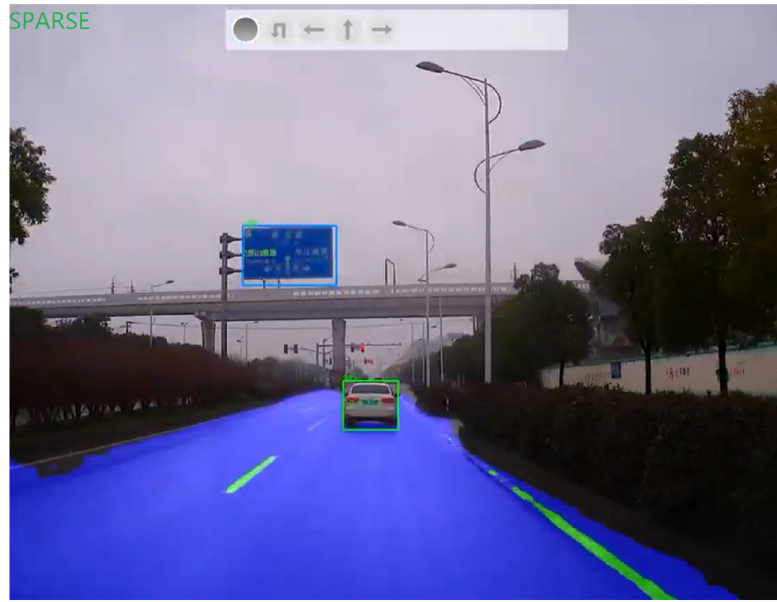
Figure 12. RTDE example output 1—SPARSE scenario.